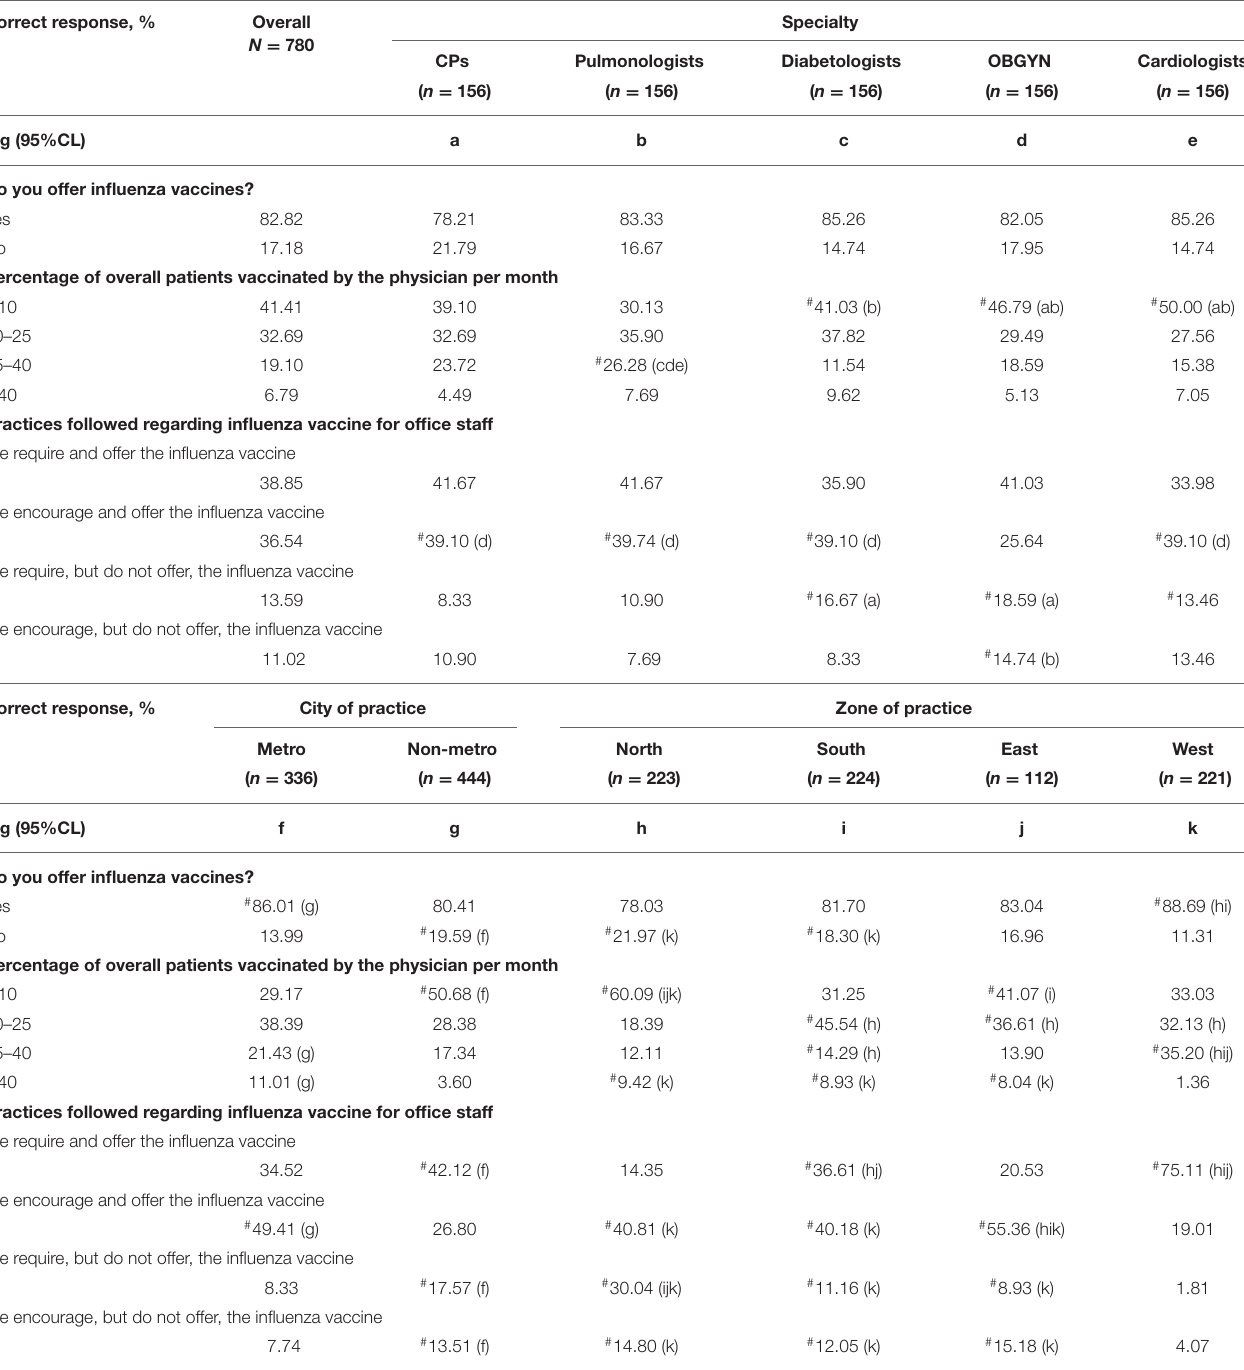
TABLE 4 | Current physician practices toward influenza vaccine administration. Correct response,